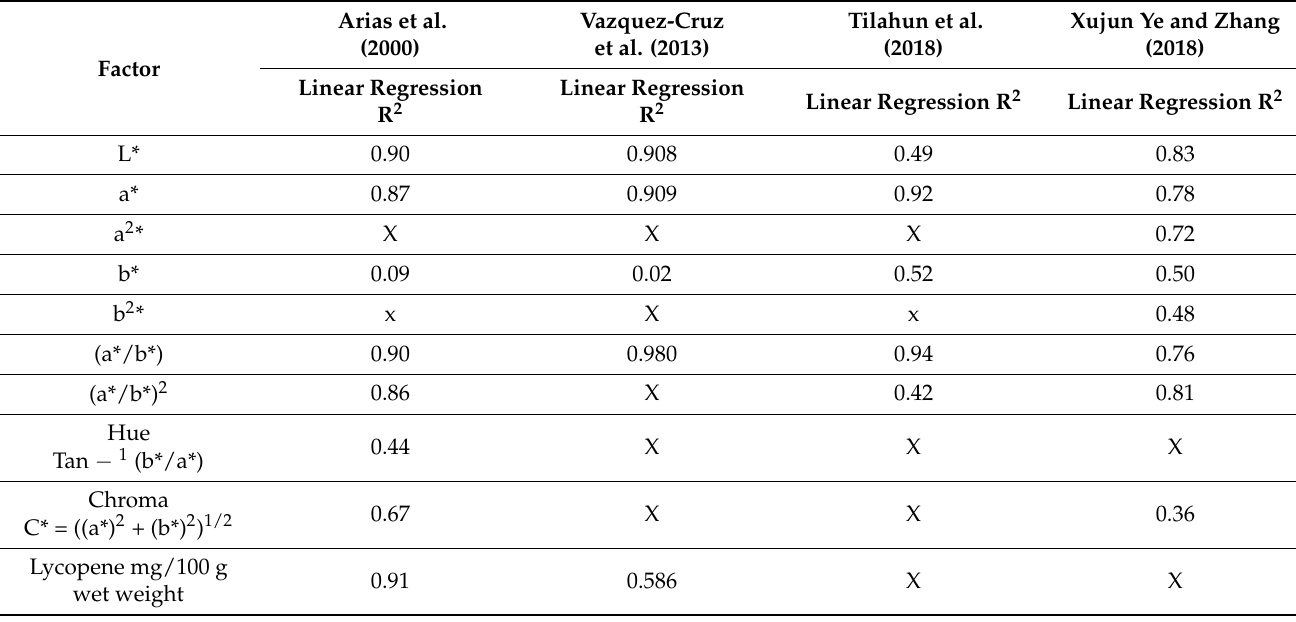
Table 3. Comparison of lycopene measurement systems using